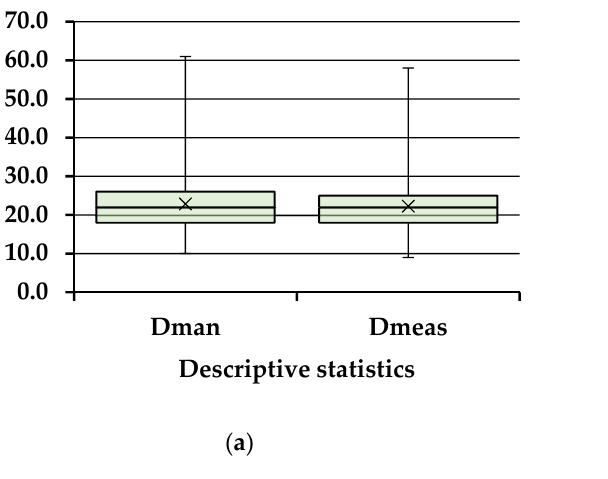
Figure 5. Descriptive statistics of the variables measured in E1: ( a ) Boxplots showing the main descriptive statistics for diameters; ( b ) Boxplots showing the main descriptive statistics for lengths.